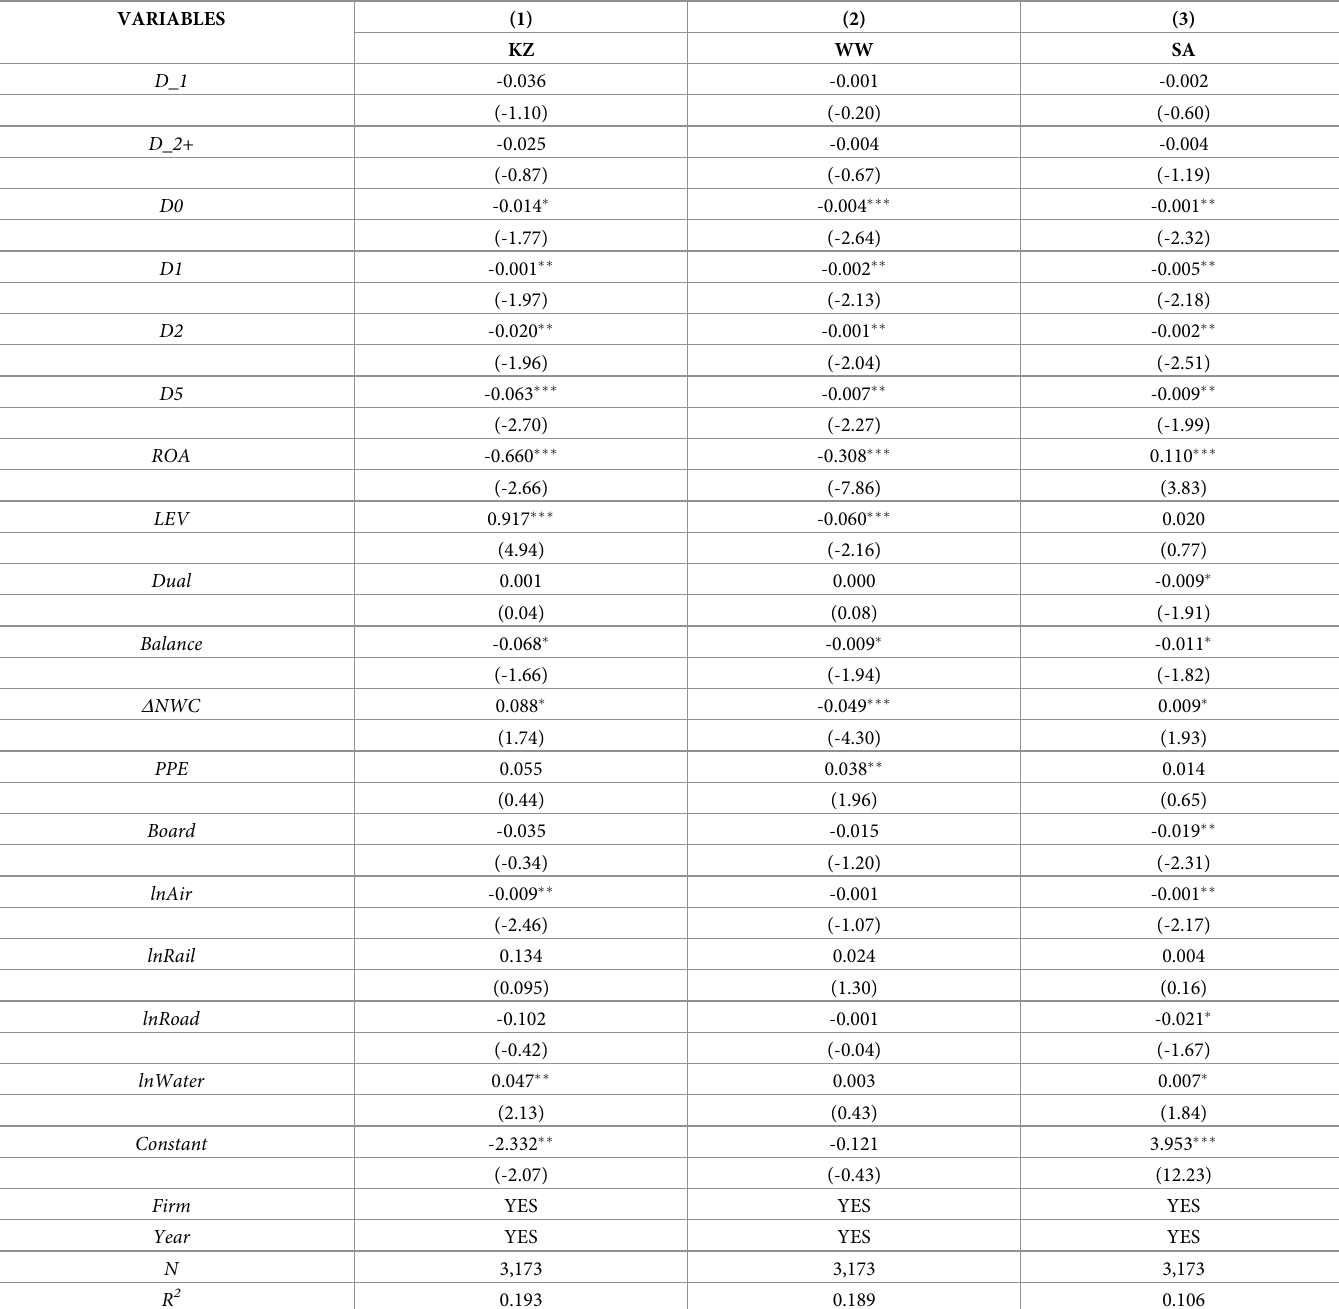
Table 7. Results of the parallel trend test.